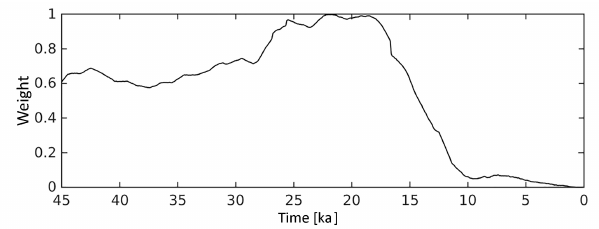
Figure A1. Transient weighting of MPI-ESM anomaly (LGM-PI). At LGM, the anomaly is fully described by MPI-ESM. CLIMBER2 anomaly weight is 1 – MPI-ESM anomaly.